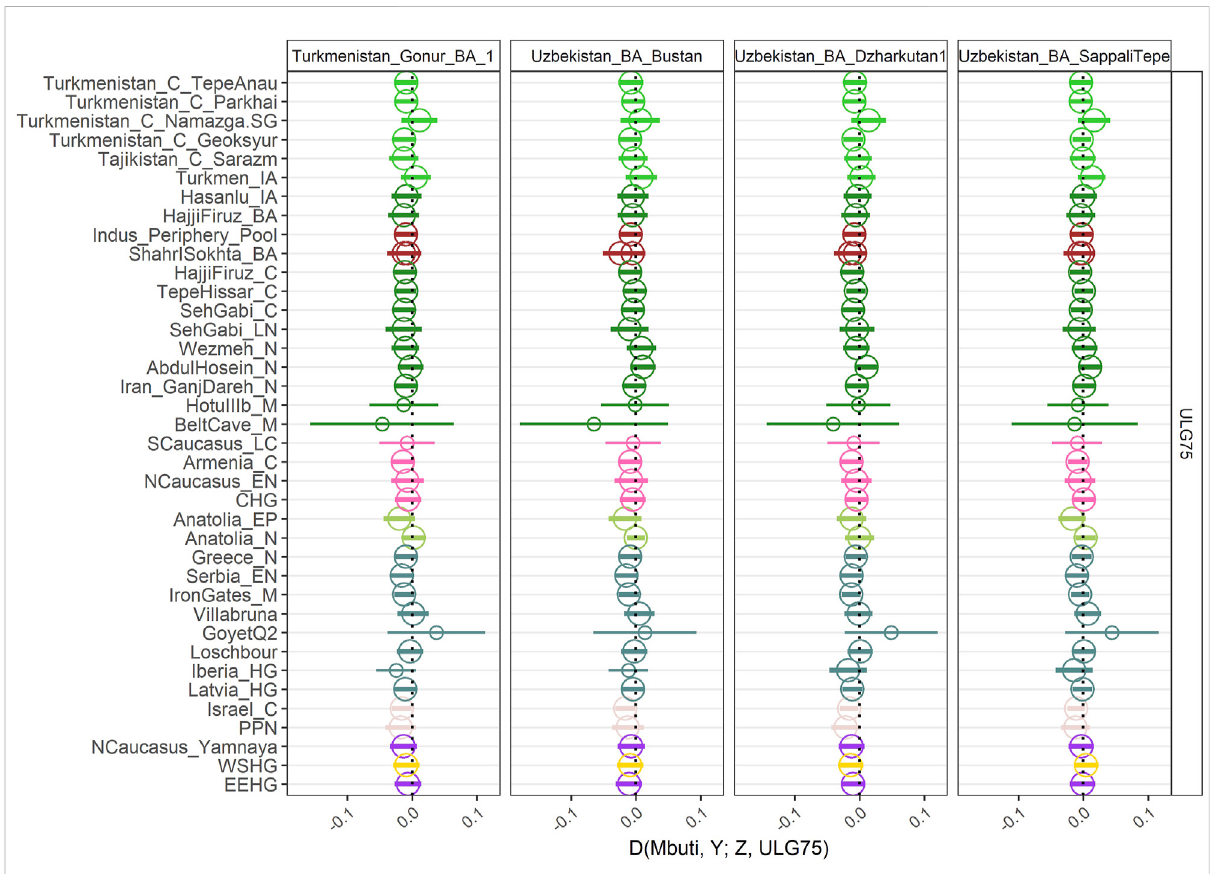
FIGURE 3 Genetic homogeneity of ULG75 with other BMAC populations. D-statistics of theform D(Mbuti, AncientPop; BMAC, ULG75 ).The hollowpoint indicates a null D-statistic (|Z| < 3). A small point indicates that the D-statistic was calculated with less than 50,000